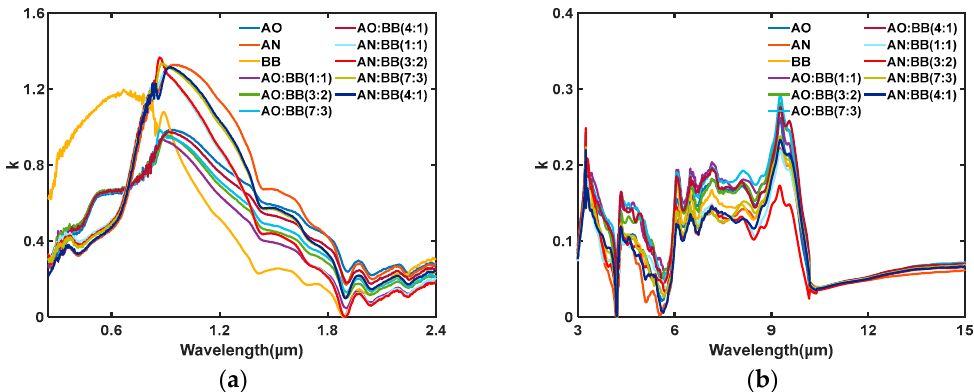
Figure 10. The imaginary part of the complex refractive indices k ( λ ) of single-germplasm biospores and compound bioaerosols. ( a ) k ( λ ) values in the 0.25–2.4 μ m wavelength range. ( b ) k ( λ ) values in the 3–14 μ m wavelength range.